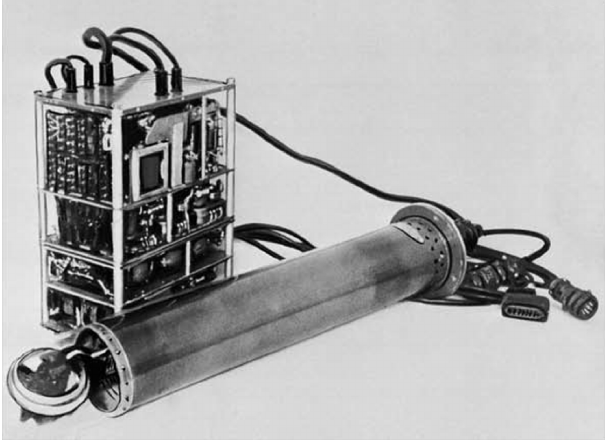
Figure 17. Magnetometer SG-45 on Sputnik 3 (Petrukovich et al.,